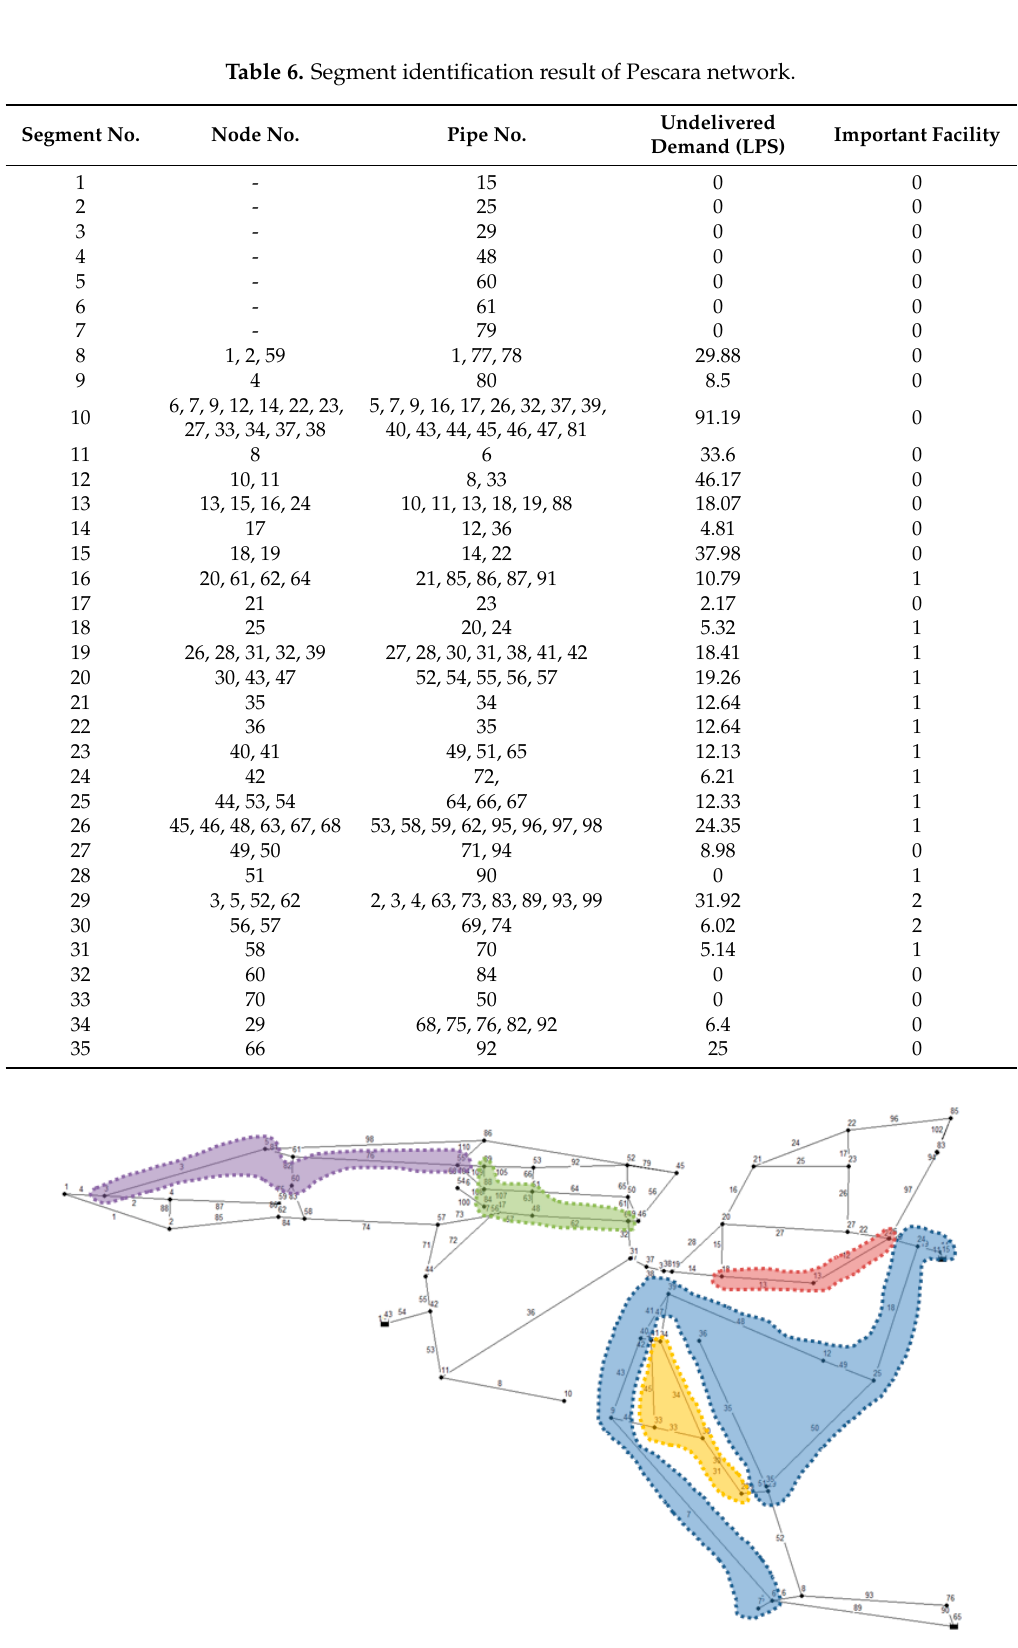
Figure 9. Result of optimal valve installation for segment division. Similarly, one valve was installed to the five segments with the highest division priority and each segment was divided into two. The 35 segments were divided into 40 by the addition of five new valves and this segment division simultaneously decreased damage. Table 8 shows the optimal valve installation for dividing the top five segments.